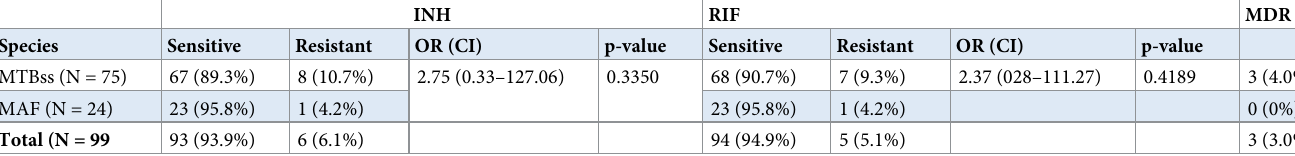
Table 3. Drug susceptibility profile of the human adapted MTBC isolates amongst TB